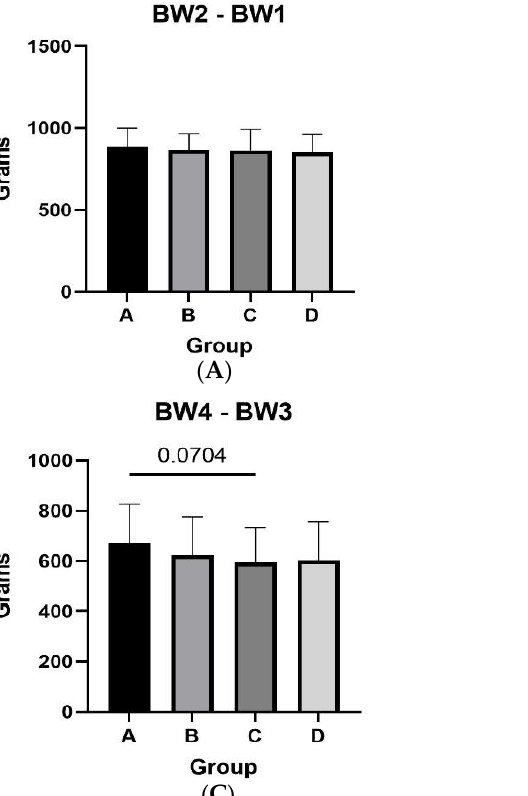
( D ) Figure 2. Body weight differences for female mink from the four experimental groups for the fol- lowing intervals: at second month of the experimental period and first month ( panel A ); at third month of the experimental period and second month ( panel B ); at fourth month of the experi- mental period and third month ( panel C ); at fifth month of the experimental period and fourth month ( panel D ). * p < 0.05. Regarding male mink, during August (BW3 and BW2), group A presented higher body weight gain compared to the rest of the groups (A vs. B, p = 0.006; A vs. C, p = 0.033; A vs. D, p = 0.058) (Figure 3). The same group also presented a tendency for higher body weight gain in September (BW4 and BW3) compared to group C ( p = 0.07). However, final